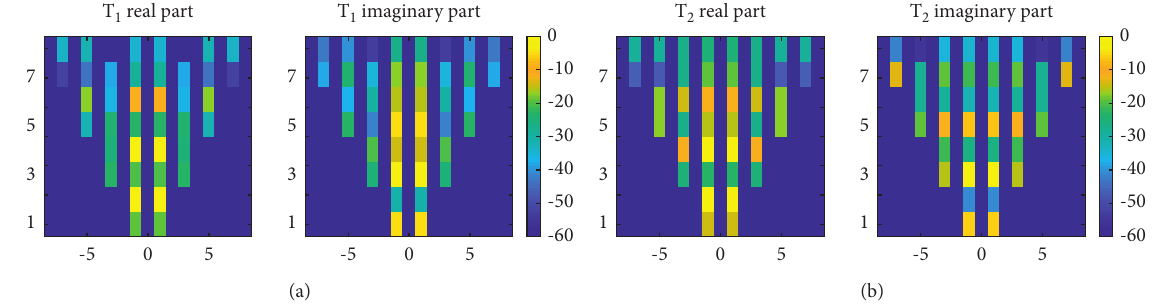
Figure 2: The magnitude distribution of real and imaginary parts of (a) T